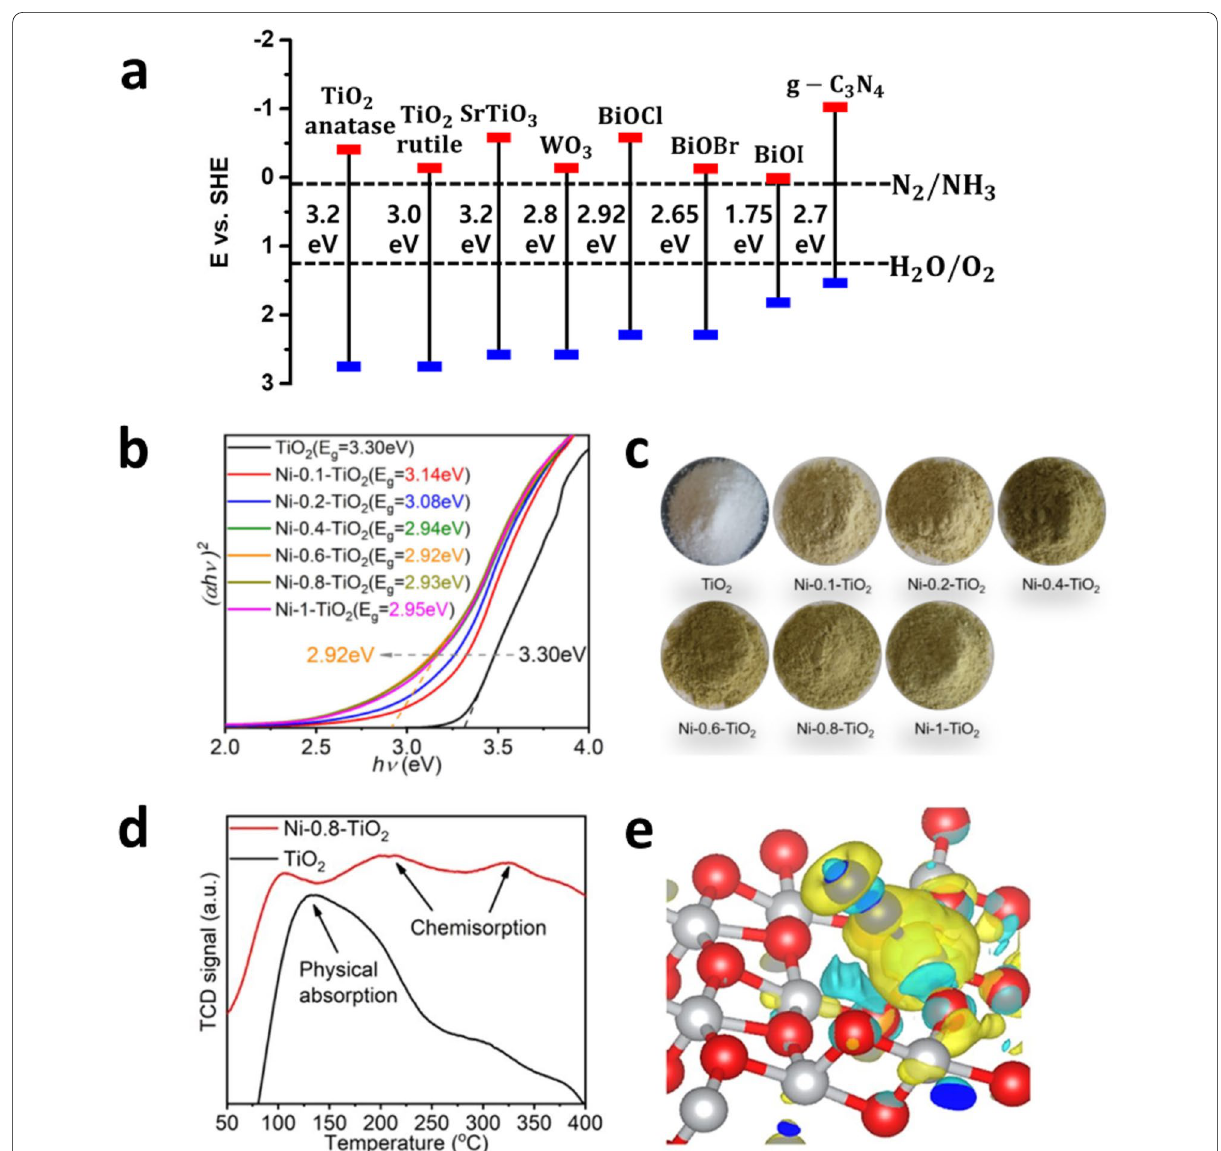
Fig. 3 a The band alignments of widely used photocatalysts. b The Tauc plot ( ahv ) 2 versus ( hv ) for the caluate the optical band gap energy E g . c The color of Ni-x-TiO 2 gradually deepens with the increase of the amount of Ni 2 + . d The N 2 -TCD spectrums of Ni-0.8-TiO 2 (red) and TiO 2 (black), respectively. e Bader charge density difference of Ni doped TiO 2 ; Ti(silver), Ni(blue), and O(red). Reproduced with permission [45]. Copyright